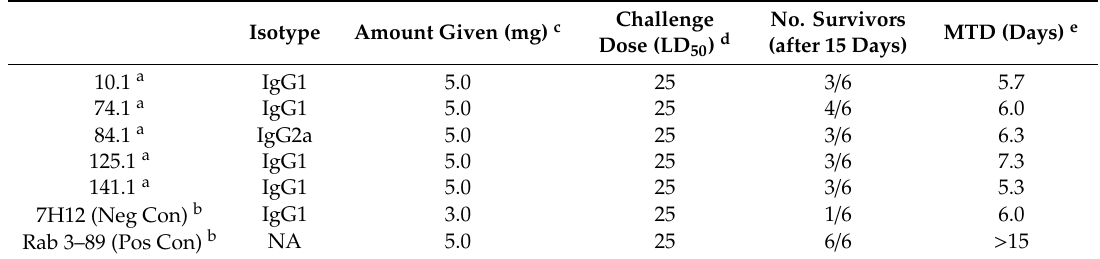
Table 2. Protection of BALB / c mice by Y. pestis anti-V mAb from an aerosol exposure to Y. pestis